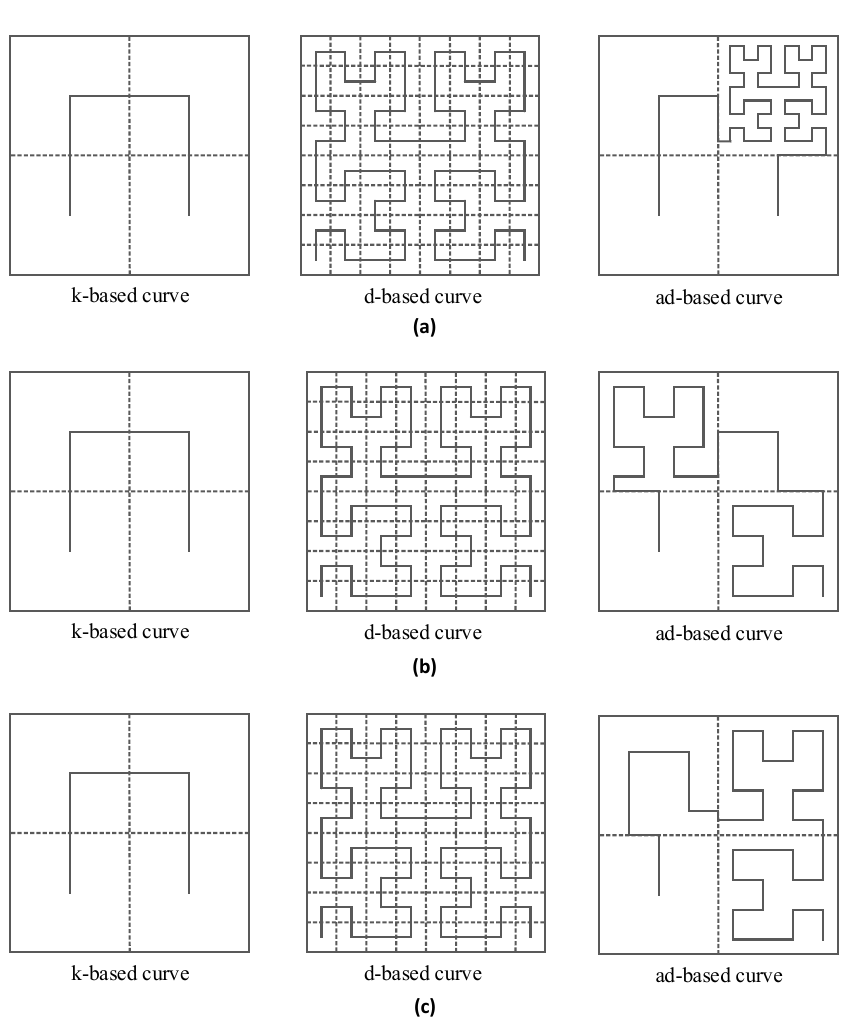
Figure 10. Illustration of k-based, d-based and adjustable d-based trajectories in Scenario 2: ( a ) the three kinds of trajectories in Figure 9a; ( b ) the three kinds of trajectories in Figure 9b; and ( c ) the three kinds of trajectories in Figure 9c.